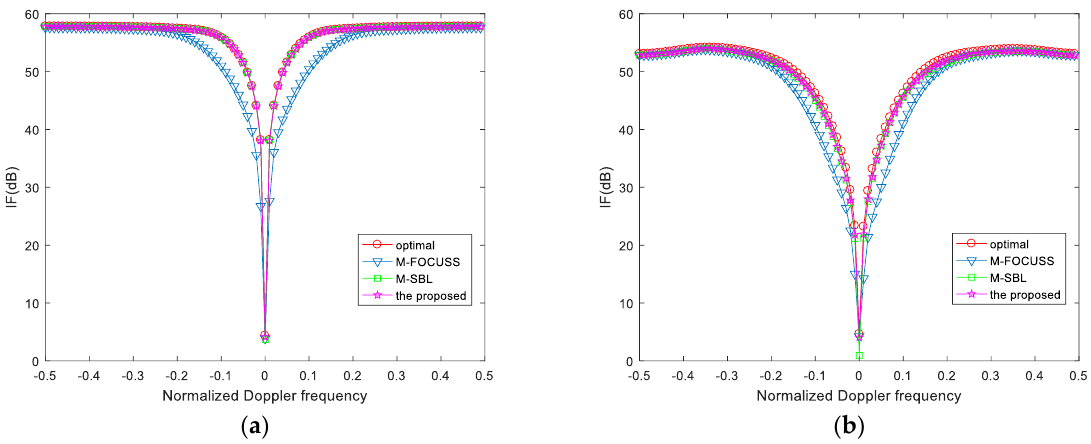
Figure 5. IF versus normalized Doppler frequency for a side-looking radar without off-grid problems. ( a ) Ideal case; ( b ) non-ideal case with array errors.